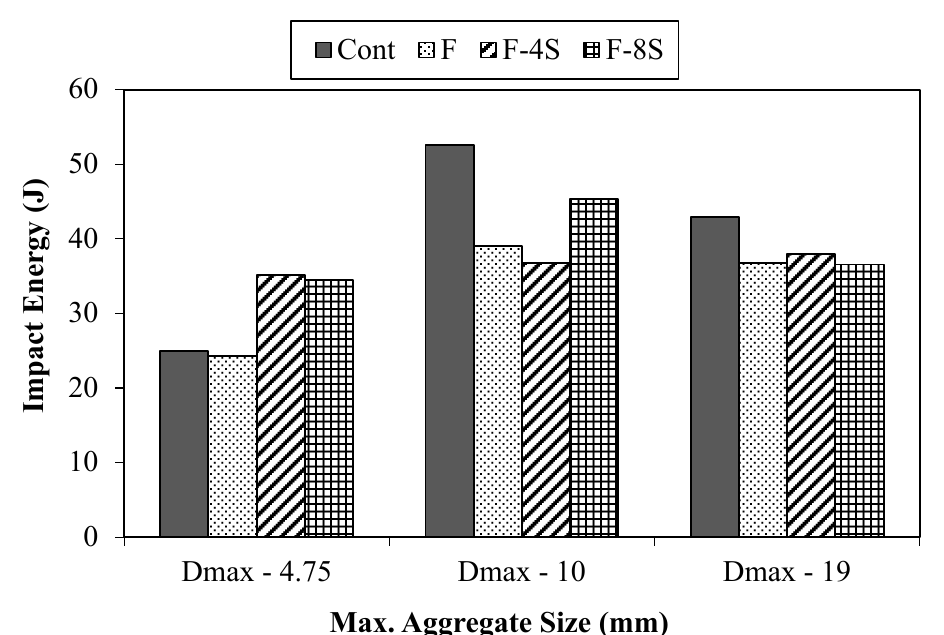
Figure 11. Results from the Charpy impact test.